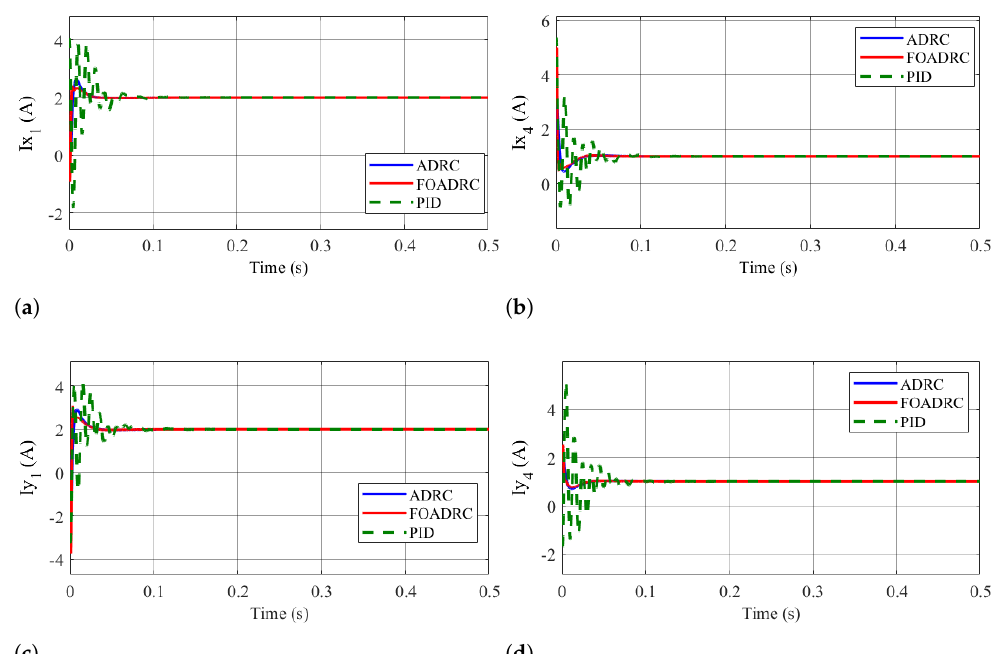
Figure 8. Control currents of the upper coils ( a , c ) and the lower coils ( b , d